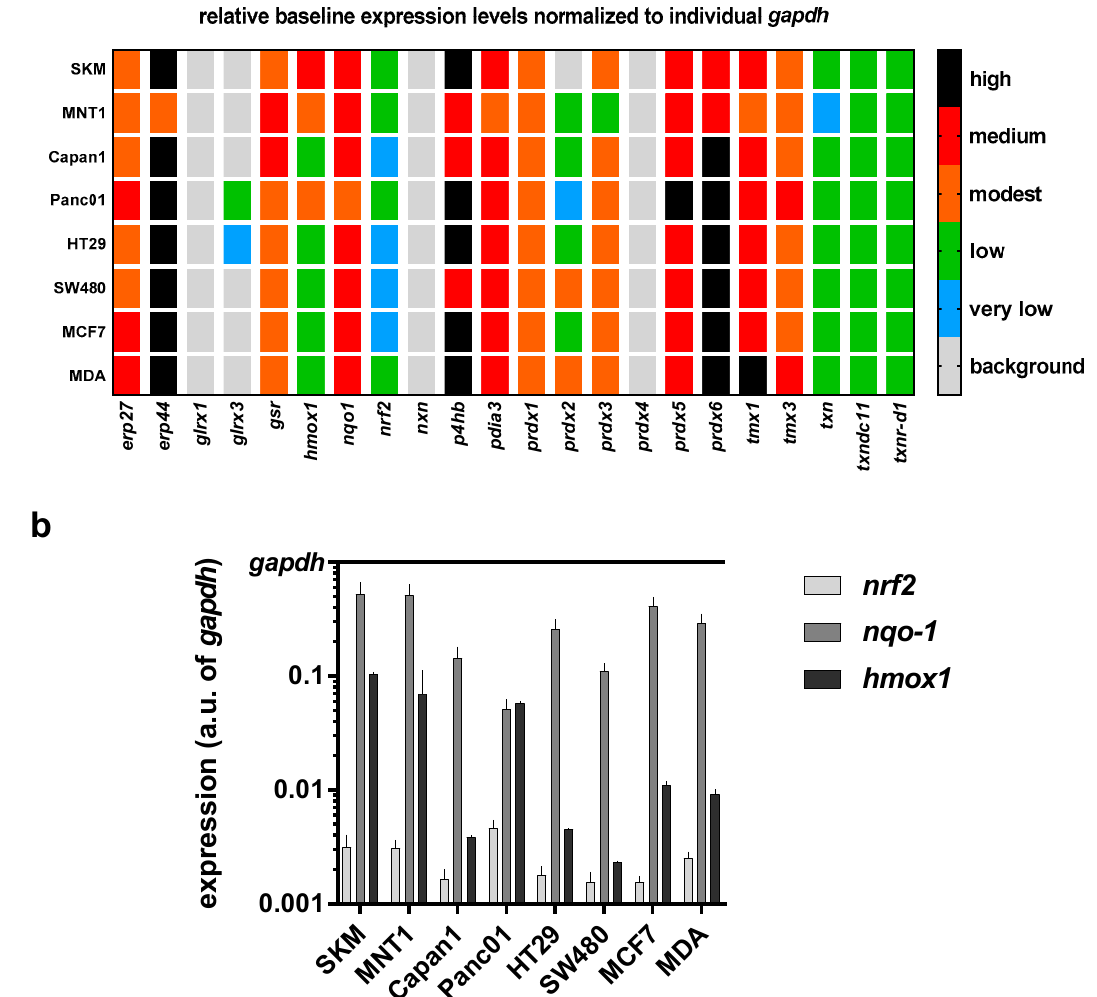
Figure 3. Heat map of transcriptional levels of 22 redox-related proteins in relation to cell line-specific levels of the house keeping gene gapdh as assessed via qPCR. ( a ) relative baseline values for all transcripts investigated in eight different human cell lines; ( b ) data from heat map represented for three targets known to respond to oxidative stress ( nrf2 , nqo1 , and hmox1 ) for better individual comparison. Data are from three to four independent experiments.